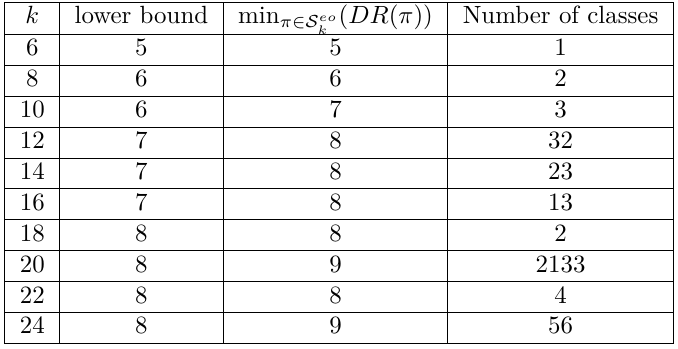
Table 5: Fibonacci lower bounds and optimal even-odd diffusion